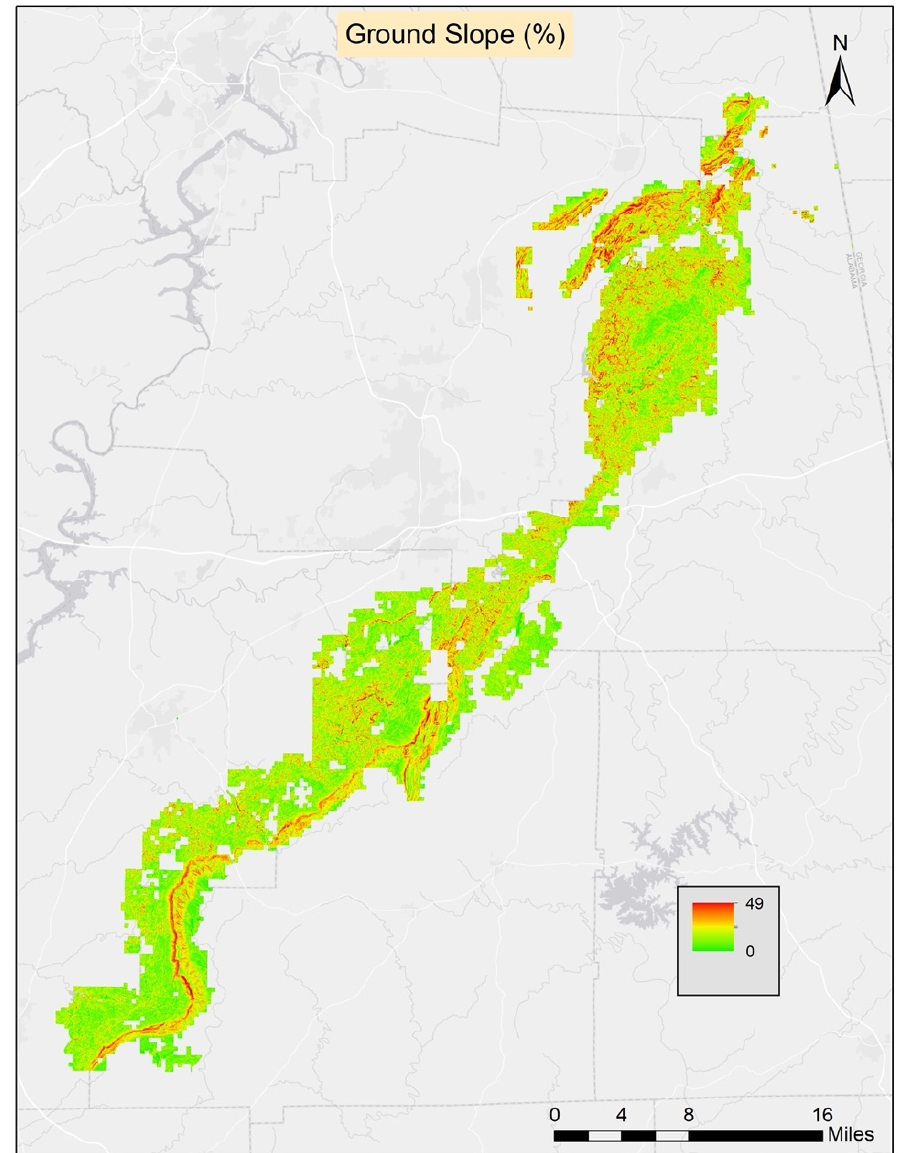
Figure A6. Ground slope for Talladega National Forest.